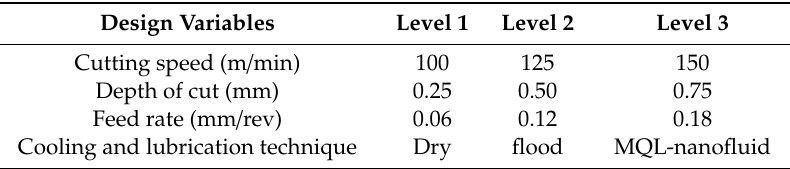
Table 2. Studied design variables and their levels.